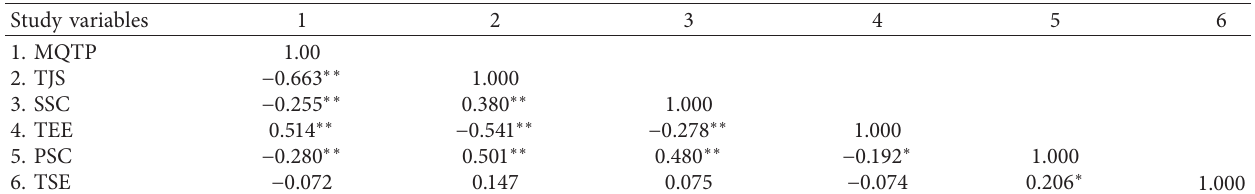
Table 5: Correlation results among the constructs in CFA.